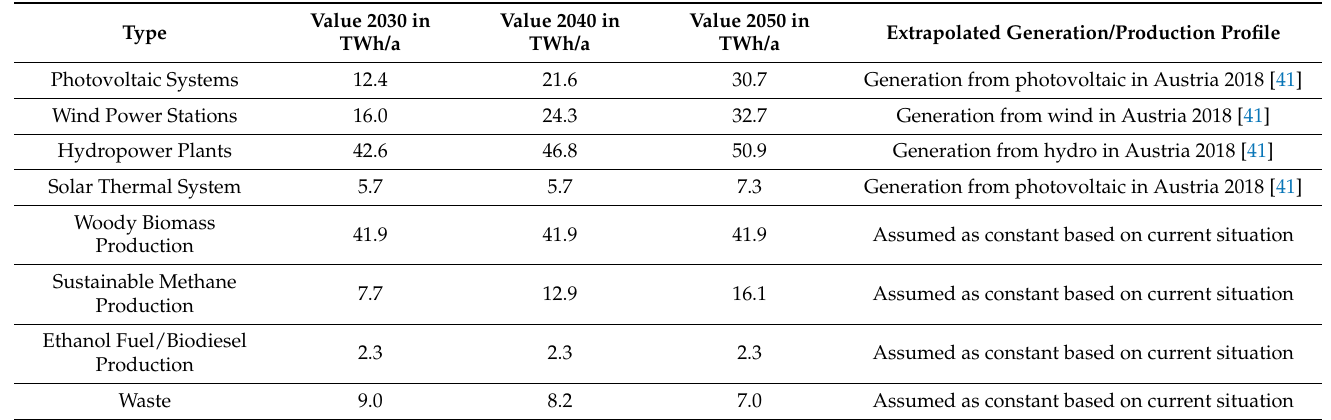
Table 1. Renewable